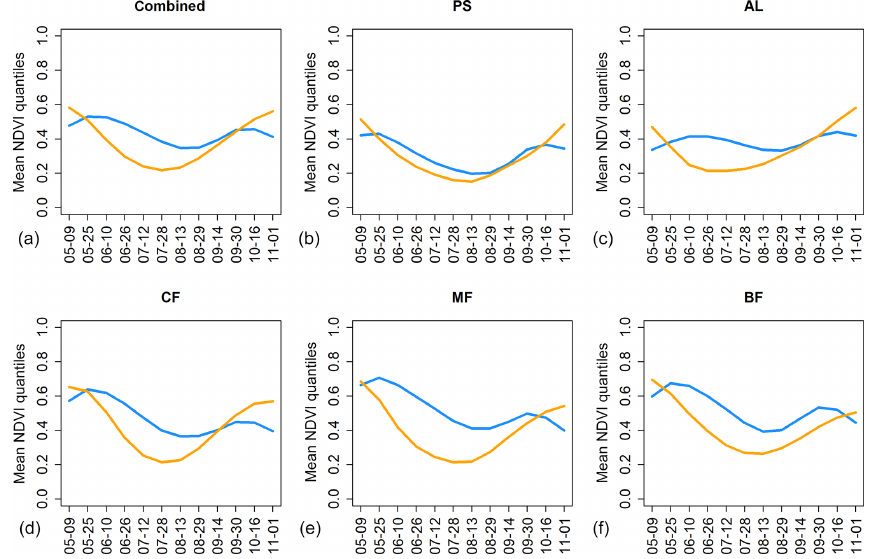
Figure 6. Time series of NDVI quantiles averaged over the regions featuring CWB < − 2 in August 2003 (blue) and July 2018 (orange) for the five different land cover classes (b–f) and a combination of those (a) . PS: pastures; AL: arable land; CF: coniferous forest; MF: mixed forest; BF: broadleaved forest. Complementary results for MODIS EVI are shown in Fig.